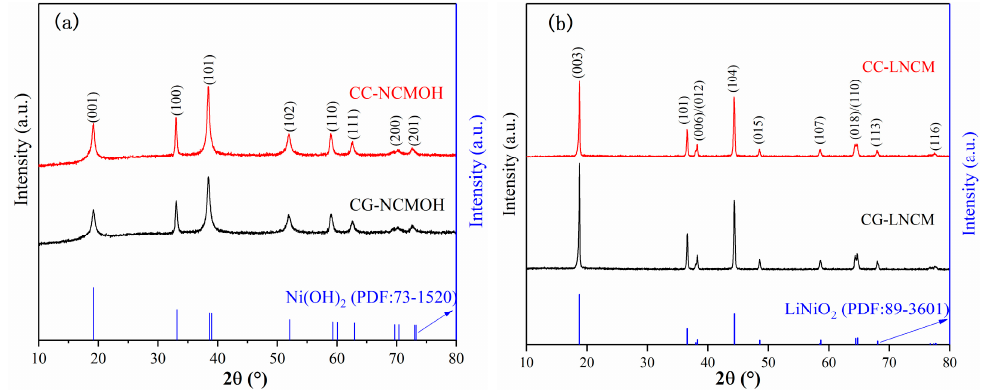
Figure 1. XRD pa tt erns of ( a ) CG-NCMOH and CC-NCMOH; ( b ) CG-LNCM and CC-LNCM. Figure 1. XRD patterns of ( a ) CG-NCMOH and CC-NCMOH; ( b ) CG-LNCM and